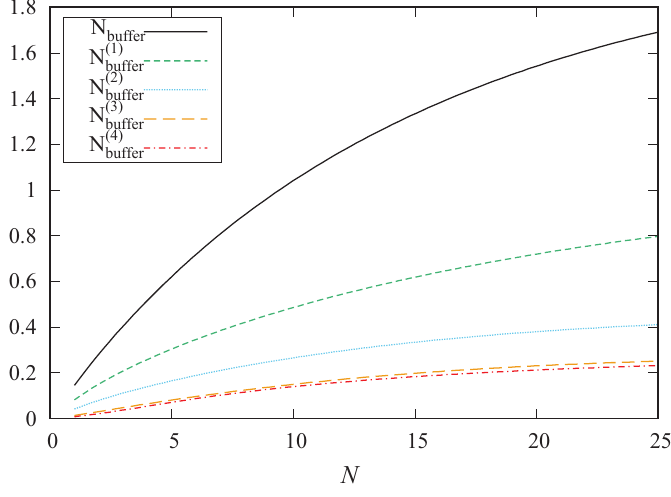
( r ) , r = 1, R , on the buffer capacity N . buf fer